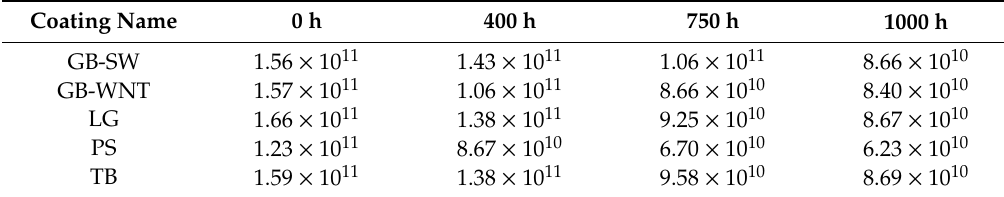
Table 4. Impedance modulus |Z| ( Ω *cm 2 ) at 10 -2 Hz after 0, 400 h, 750 h, and 1000 h.